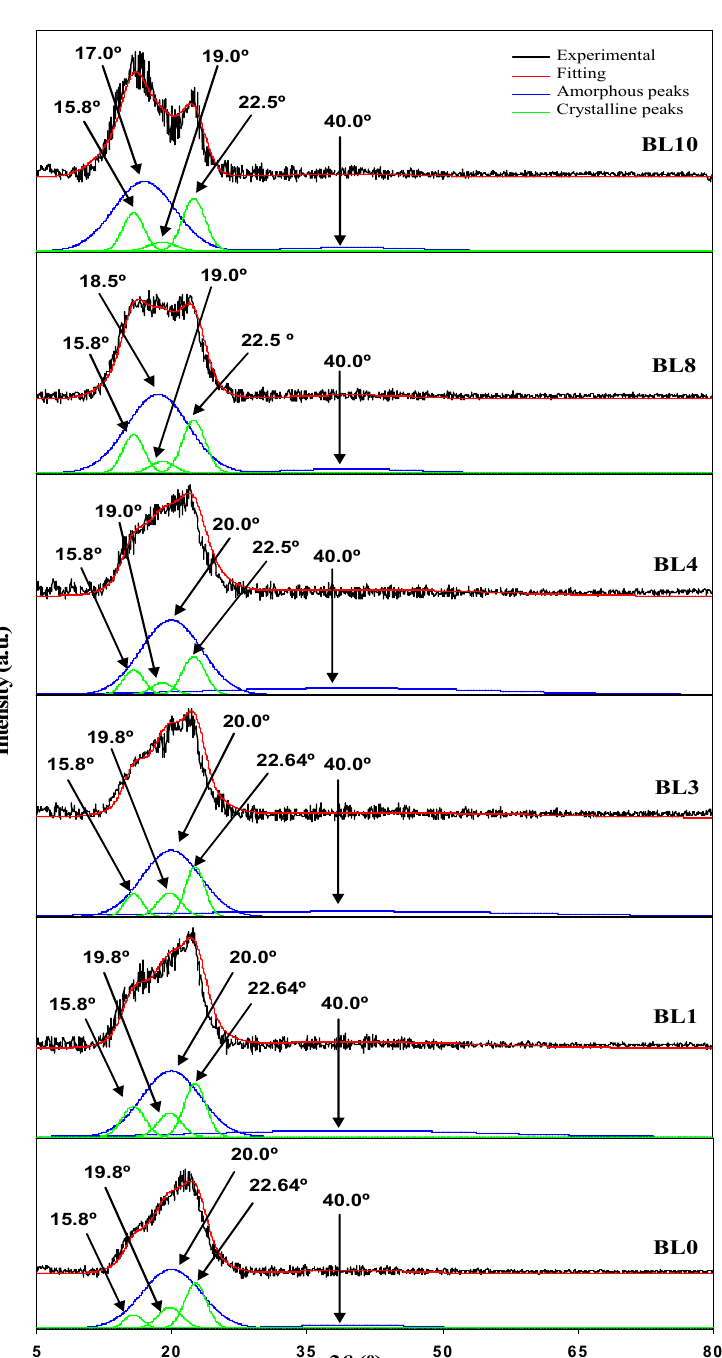
Figure 2. Deconvoluted XRD patterns for the polymer blend. Table 3. Designation for the polymer blend systems and their respective degree of crystallinity.